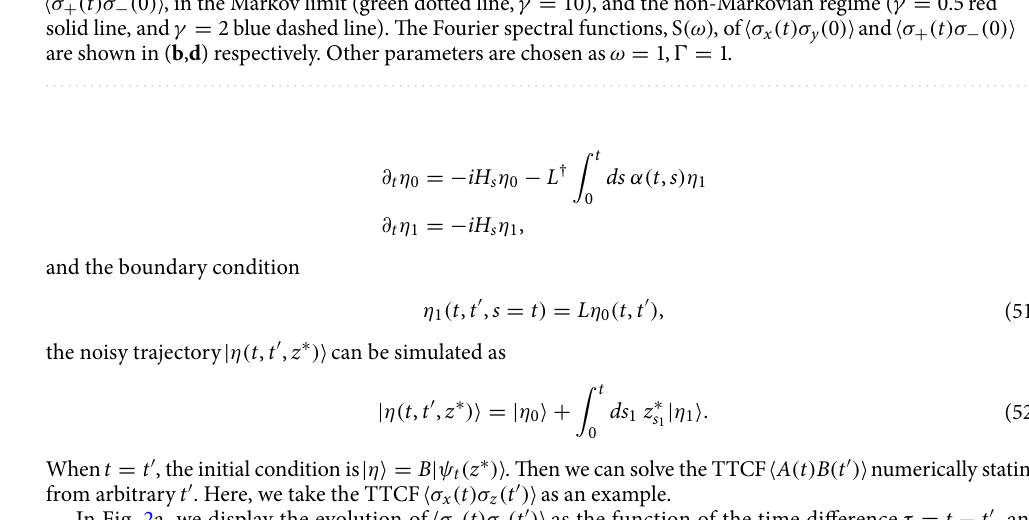
Figure 1. Dynamics of two-time correlation functions in the short-time limit for ( a ) σ ( t )σ ( 0 ) , in the Markov limit (green dotted line, γ � � + − 2 blue dashed line). The Fourier spectral functions, S (ω) , of solid line, and γ = are shown in ( b , d ) respectively. Other parameters are chosen as ω